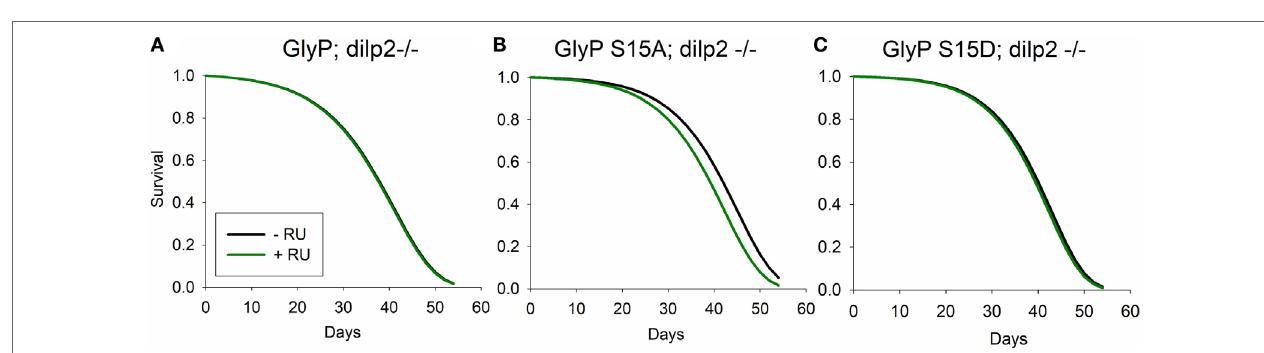
FigUre 5 | Glycogen phosphorylase (GlyP) phosphorylation is required for longevity conferred by mutation of dilp2 . Survival calculated from life tables based on estimated Gompertz mortality parameters for UAS-GlyP expression in a dilp2 mutant background with transgenes driven by systemic DaGS-Gal4. Gompertz mortality scale (l, frailty) parameters of transgene expression genotypes were adjusted for the impact of RU alone upon mortality estimated from control genotypes. (a) Overexpression of wild-type GlyP does not extend longevity (Cox hazard analysis, χ 2 = 0.1, p = 0.76), (B) expression of GlyP S15A decreases lifespan (Cox hazard analysis, χ 2 = 24.2, p < 0.0001), and (c) expression of GlyP S15D does not extend longevity (Cox hazard analysis, χ 2 = 1.2, p = 0.28). Each genotype cohort n = 351–361 adults.